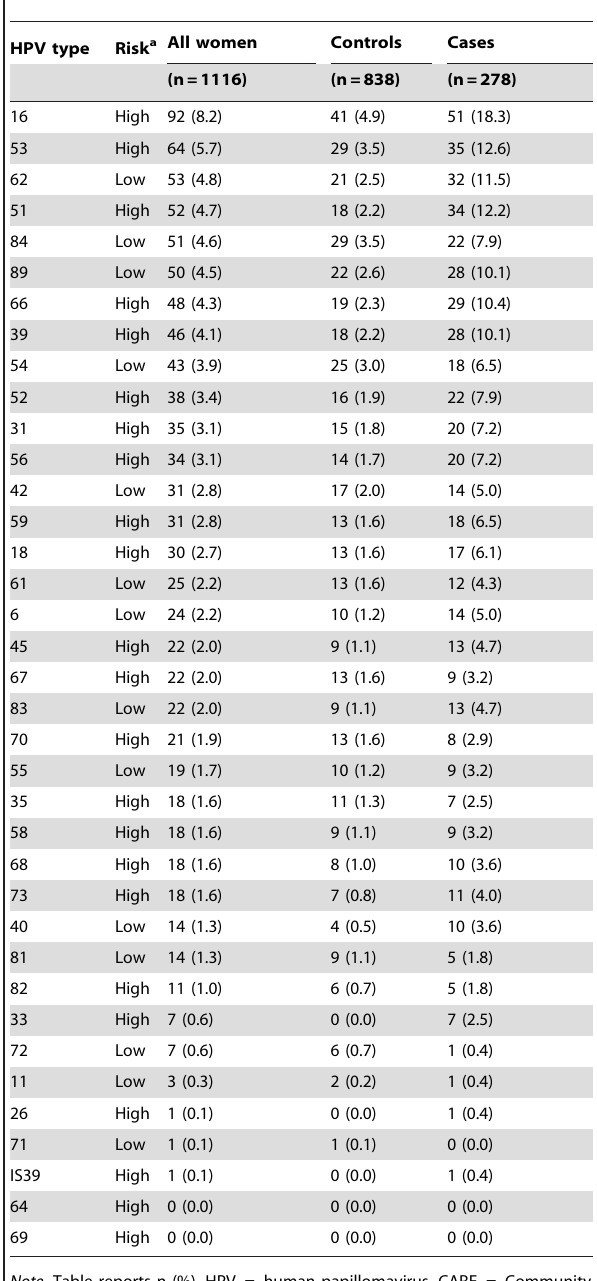
Table 3. Prevalence of HPV types among women from the CARE